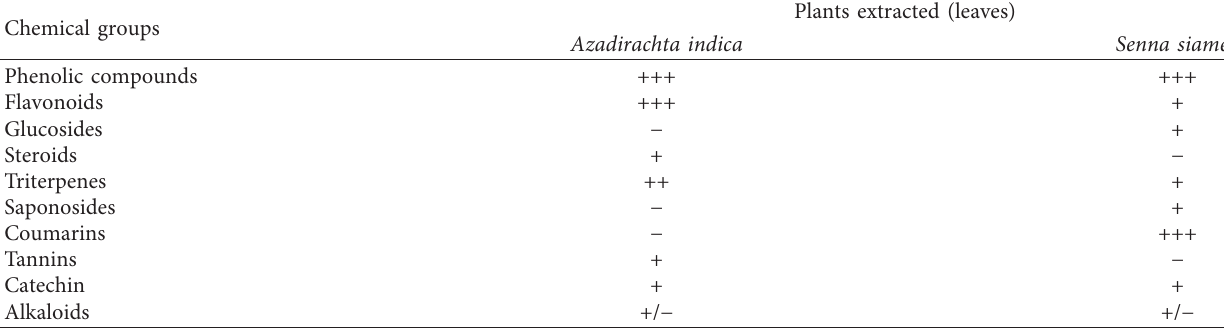
Table 2: Phytochemical screening of each extract of the decoction.